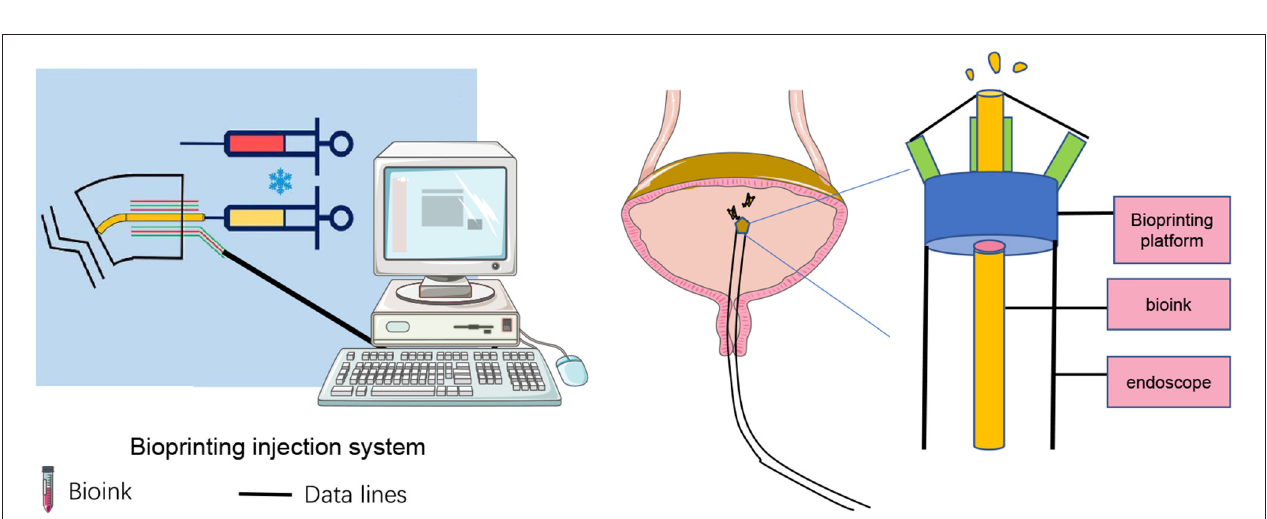
FIGURE 3 | Schematic of in situ in vivo bioprinting taking the case of bladder augmentation. (A) UCs and SMCs were harvested from biopsy material; (B) UCs and SMCs proliferated in vitro ; (C) Bioinks containing UCs and SMCs; (D) in situ in vivo bioprinting after bladder augmentation with biomaterial. UCs, urothelial cells; SMCs, smooth muscle cells.